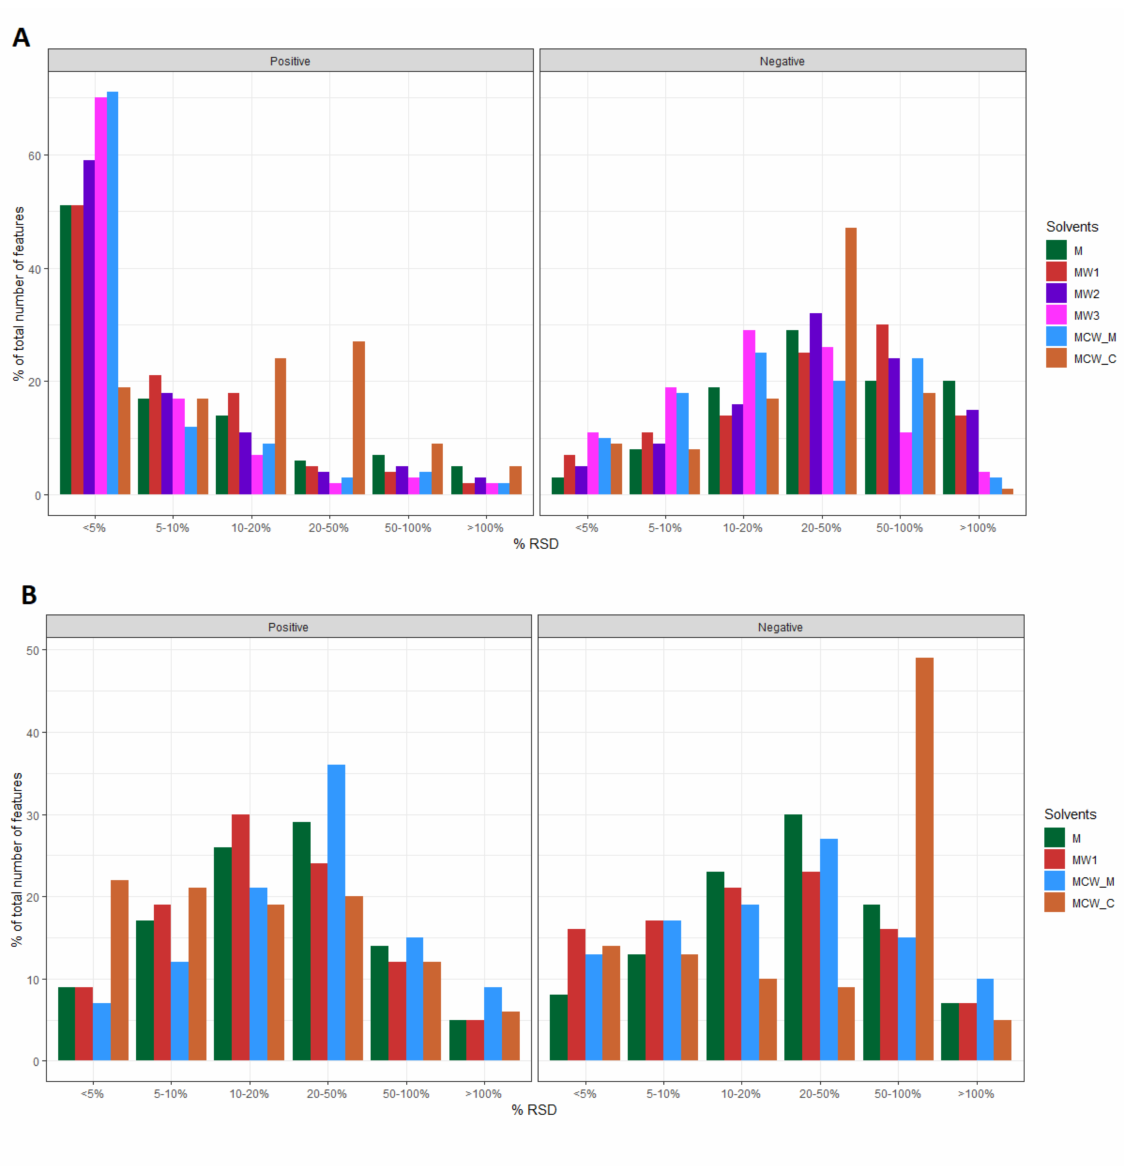
Figure 3. Distribution of relative standard deviation (RSD%) of metabolite features ( m / z ) among different solvent extractions for each reactor and ionisation mode. ( A ) Reactor A in both positive (left panel) and negative (right panel) ionisation modes; ( B ) Reactor B in positive (left panel) and negative (right panel) ionisation